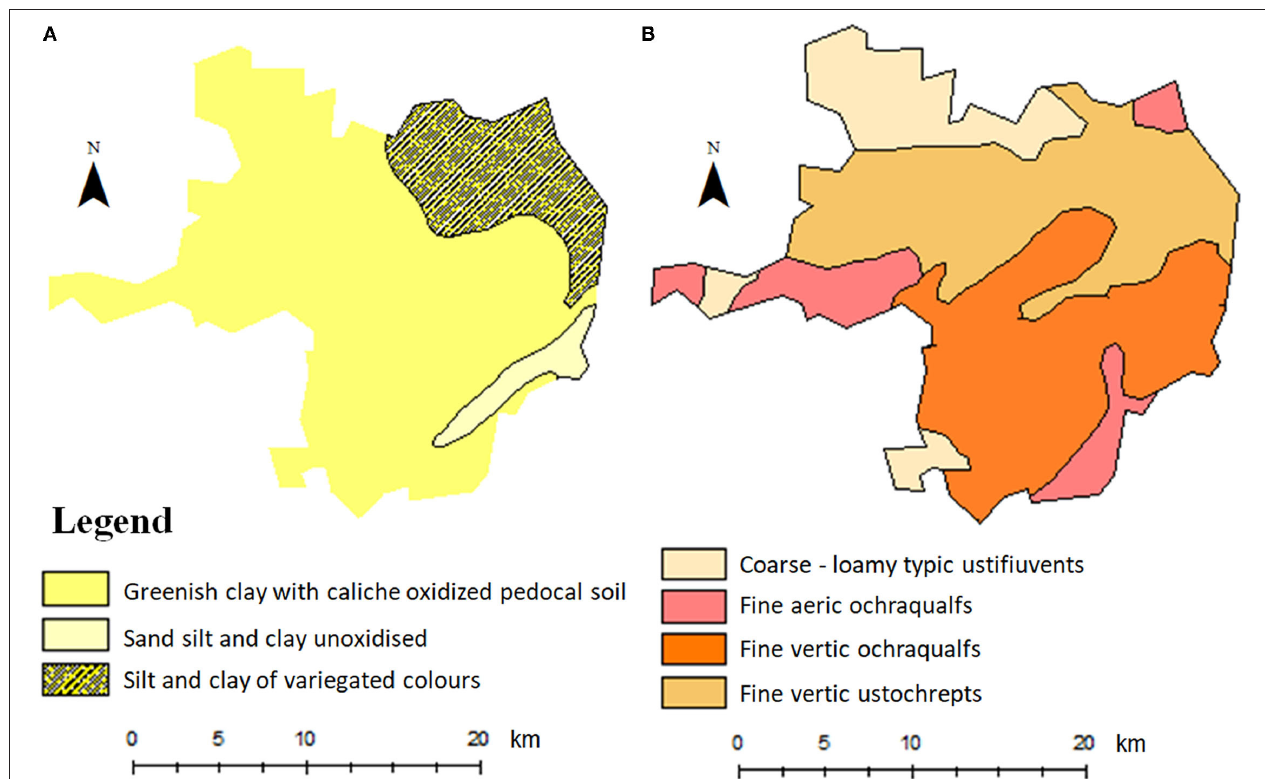
FIGURE 2 | Soil maps (A) soil type, (B) dominant soil subgroups (source: NATMO, Kolkata,